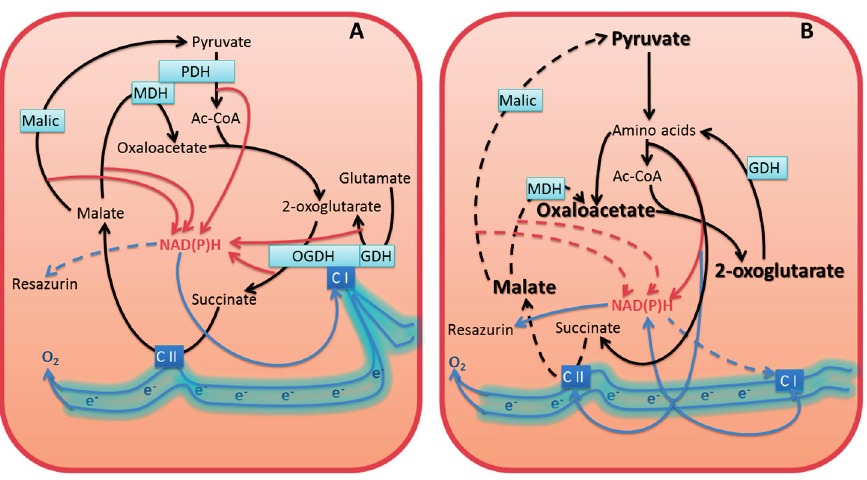
Figure 6. Potential changes in the electron flow to resazurin in normal ( A ) and perturbed ( B